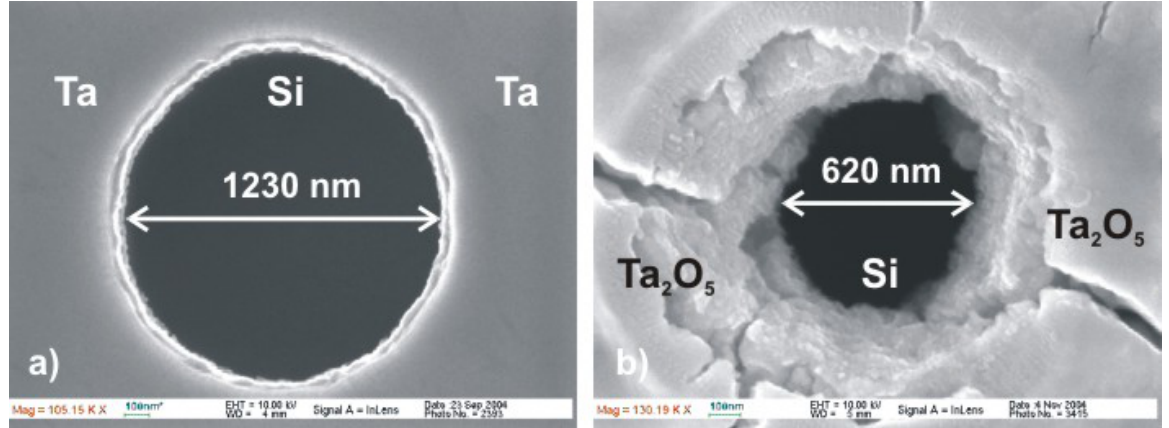
Figure 2. Scanning electron microscopy picture of prepared nano-slit before (a) and after (b) Ta oxidation. A pattern-size reduction of about 1100 nm or by a factor of more than 4 has been achieved.